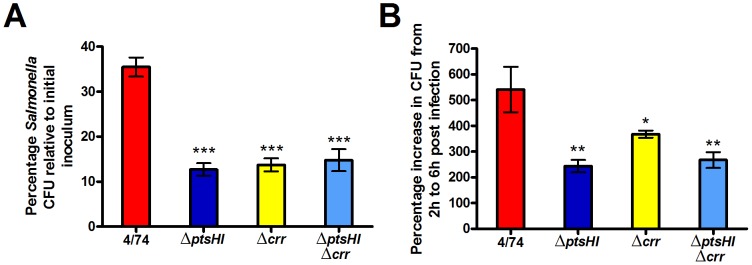
The PTS-system is important but not essential for the invasion and intracellular replication of HeLa cells in S. Typhimurium.Invasion (A) and intracellular replication (B) of S. Typhimurium 4/74, ΔptsHI (JH3537), ΔptsHIcrr (JH3536) and Δcrr (JH3502), strains during infection of HeLa cells. (A) The chart shows the numbers of viable bacteria (expressed as percentages of the initial inoculum) within host cells at 2 h post-infection. (B) The chart shows the percentage replication of bacteria between 2 h and 6 h. Each bar represent the statistical mean from three biological replicates and the error bars represent the standard deviation (The significant differences between the parental 4/74 strain and the mutant strains are shown by asterisks *p<0.05, **p<0.01, and ***p<0.001).